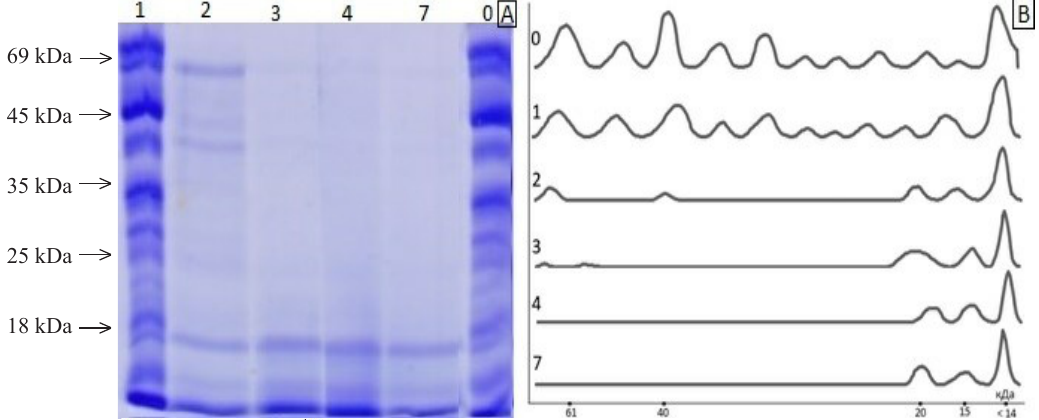
Figure 6 Electrophoregram (A) and profilogram (B) of the molecular weight distribution of proteins in the hydrolysate after 0, 1, 2, 3, 4, and 7 h